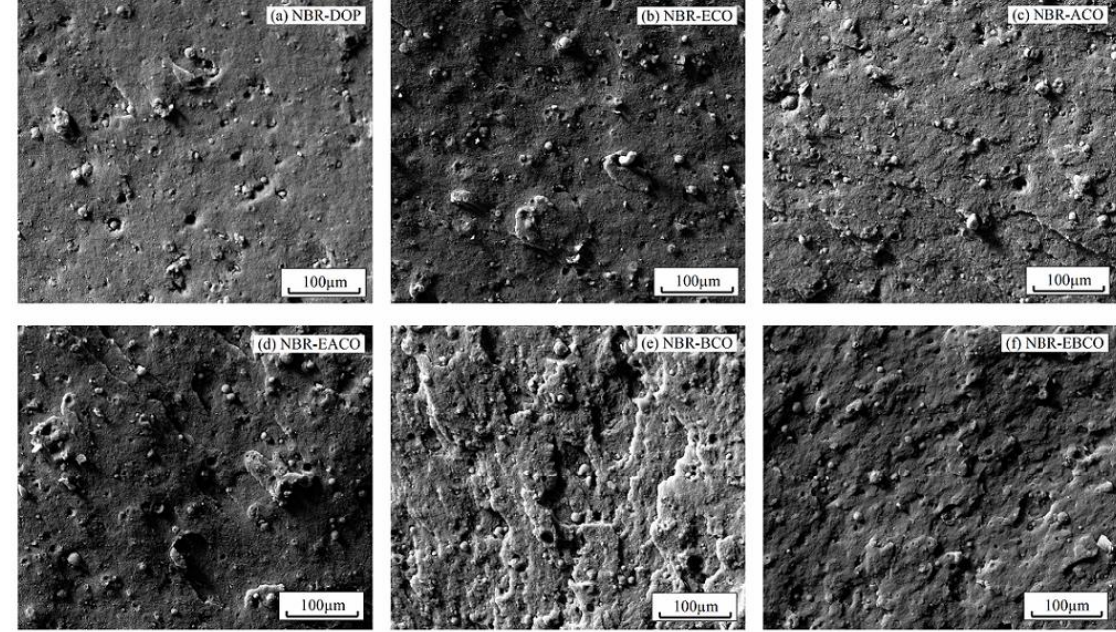
Figure 8. SEM images of ( a ) NBR-DOP, ( b ) NBR-ECO, ( c ) NBR-ACO, ( d ) NBR-EACO, ( e ) NBR-BCO and ( f ) NBR-EBCO.